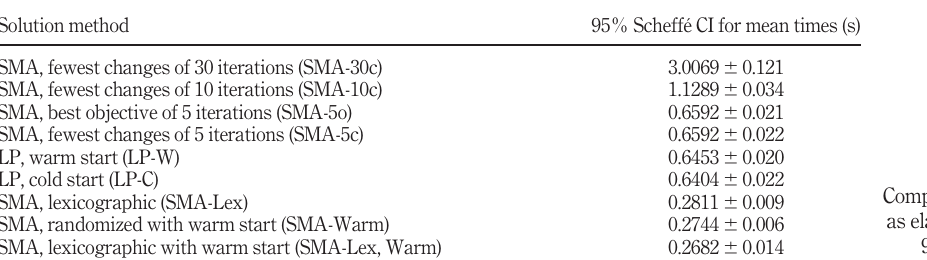
Table 3. Computational effort